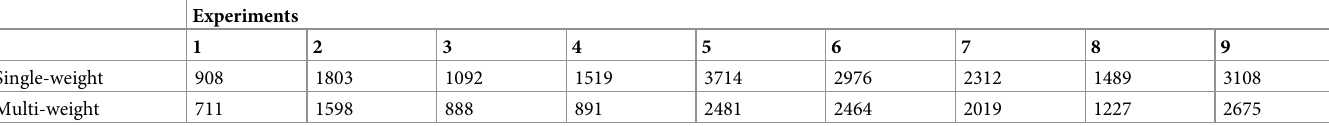
Table 1. Akaike information criterion. AIC values of single- and multi-weight model fit for every